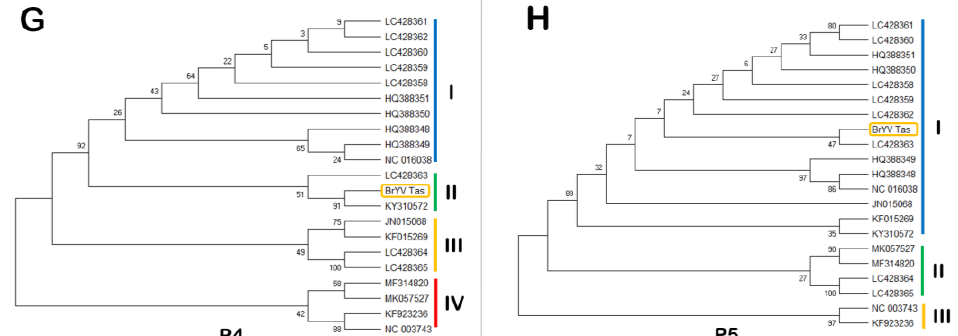
Figure 2. Phylogenetic trees (maximum likelihood algorithm) based on nucleotide sequence align- ments of Brassica Yellows Virus (BrYV) constructed in MEGA-X. Bootstrap values shown at the nodes indicate the percentage of 1000 replications supporting the branching patterns shown. Phylogenetic analysis includes full/near-full genomes ( A ) and each gene responsible to encode their respective proteins ( B ) P0, ( C ) P1, ( D ) P1-P2, ( E ) P3, ( F ) P3-P5, ( G ) P4, and ( H ) P5. The accessions with red, green, and blue rectangles represent BrYV genotypes A, B, and C, respectively. Yellow rectangles indicate the BrYV-Tas isolate from the present study. Additional information regarding all these isolates is given in Table 2. Table 2. BrYV and TuYV reference isolates retrieved from GenBank. Isolate Accession No.